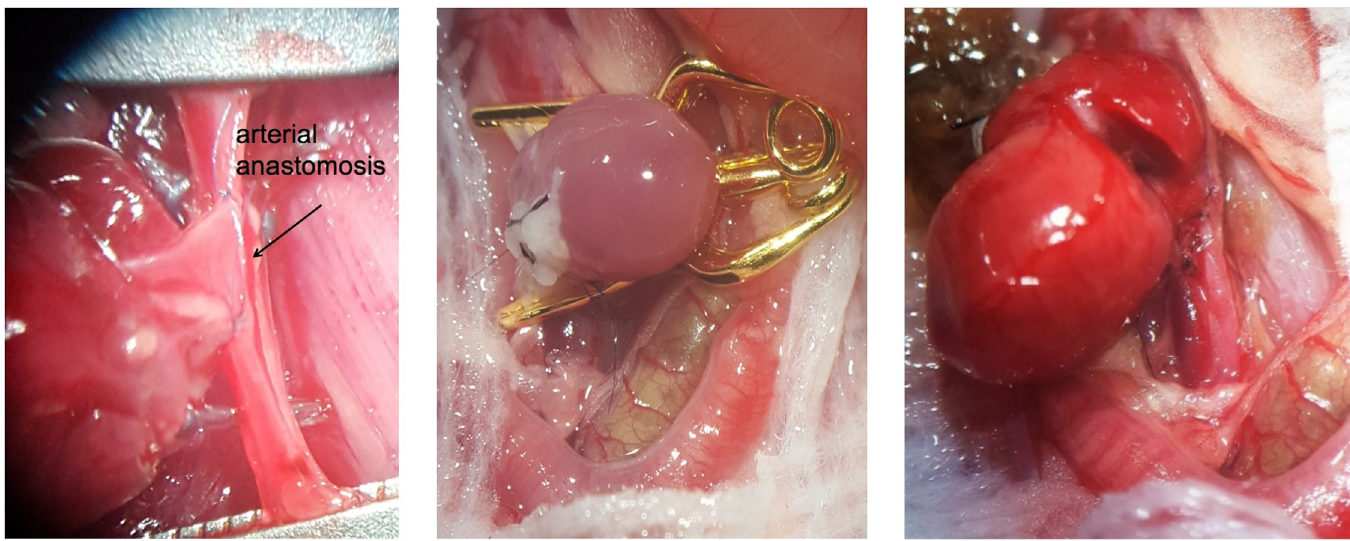
Fig 7. a-c: Photographic illustration of the heterotopic transplantation . Fig 7A shows the finished left side of the arterial anastomosis, afterwards the heart is being flipped over for the right side of the arterial anastomosis. Fig 7B and 7C show the transplanted heart after finishing all anastomoses. Fig 7B shows the transplanted heart before de-clamping. Fig 8C shows the heart which is directly perfused following removal of the clamps.